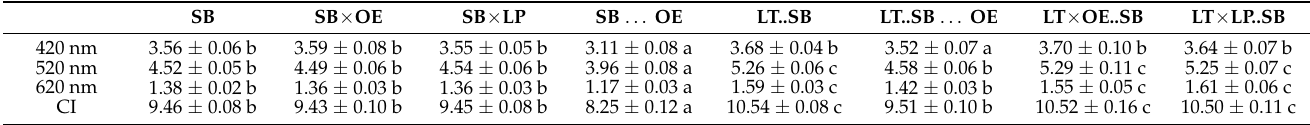
Table 3. Final color analysis of fermentations from Tempranillo red grapes: S. bayanus alone (SB); coinoculation of S. bayanus and O. oeni (SB × OE); coinoculation of S. bayanus and L. plantarum (SB × LP); sequential fermentation with S. bayanus and O. oeni after alcoholic fermentation (SB . . . OE); sequential fermentation with S. bayanus and L. thermotolerans during alcoholic fermentation (LT..SB); sequential fermentation with S. bayanus and L. thermotolerans during alcoholic fermentation, followed by O. oeni after alcoholic fermentation (LT..SB . . . OE); coinoculation of L. thermotolerans and O. oeni, followed by S. bayanus (LT × OE..SB); and coinoculation of L. thermotolerans and L. plantarum, followed by S. bayanus (LT × LP..SB).